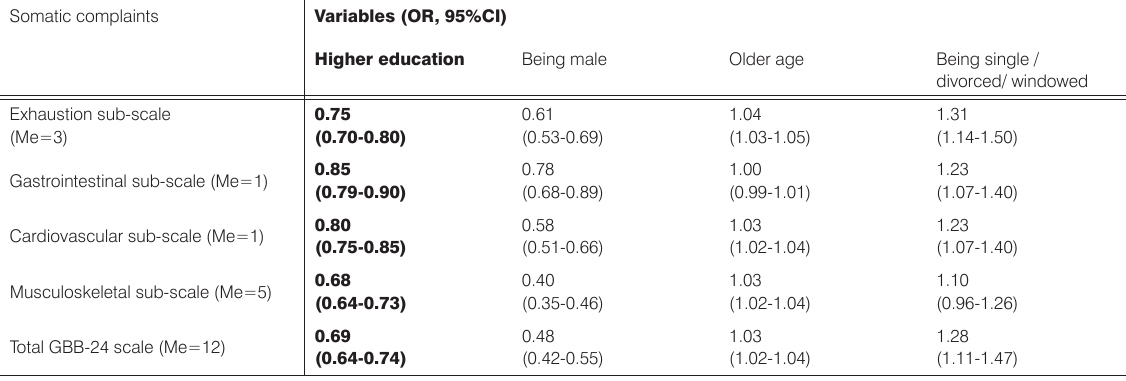
Table 3. Logistic regression analysis of the relation between high levels of somatic symptoms (sub-scales and total), education, age and marital status. Somatic